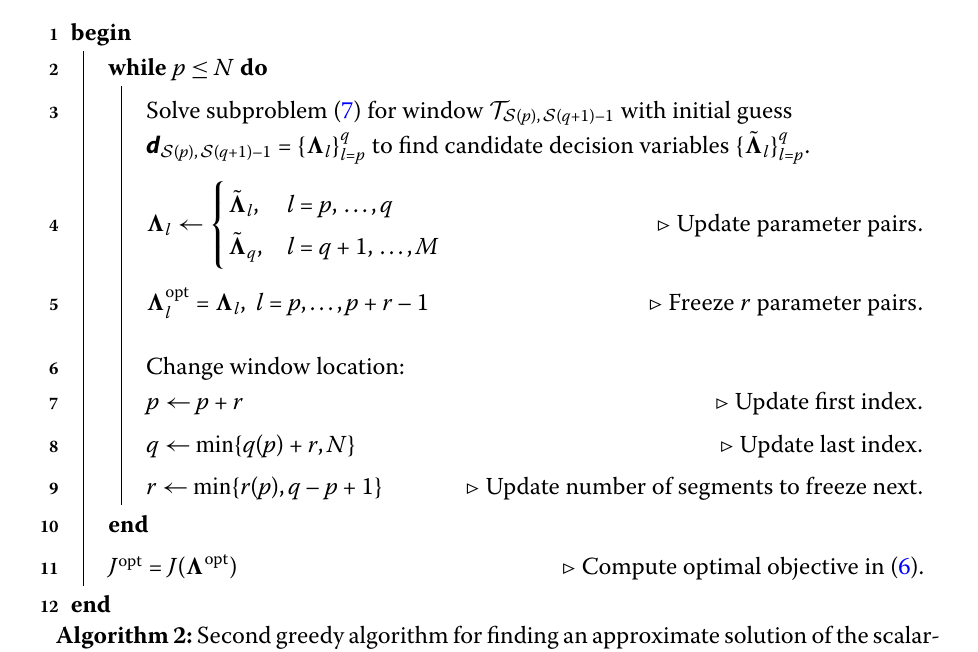
Algorithm 2: Second greedy algorithm for finding an approximate solution of the